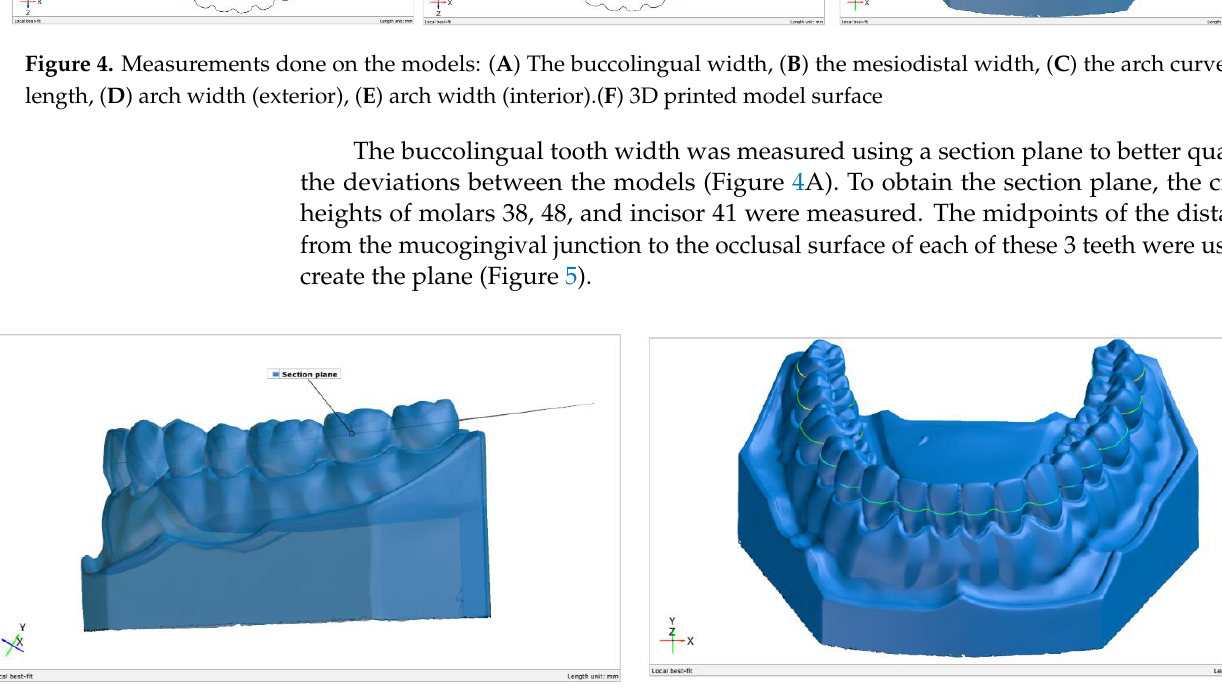
Figure 5. Section plane used for the buccolingual width measurements.